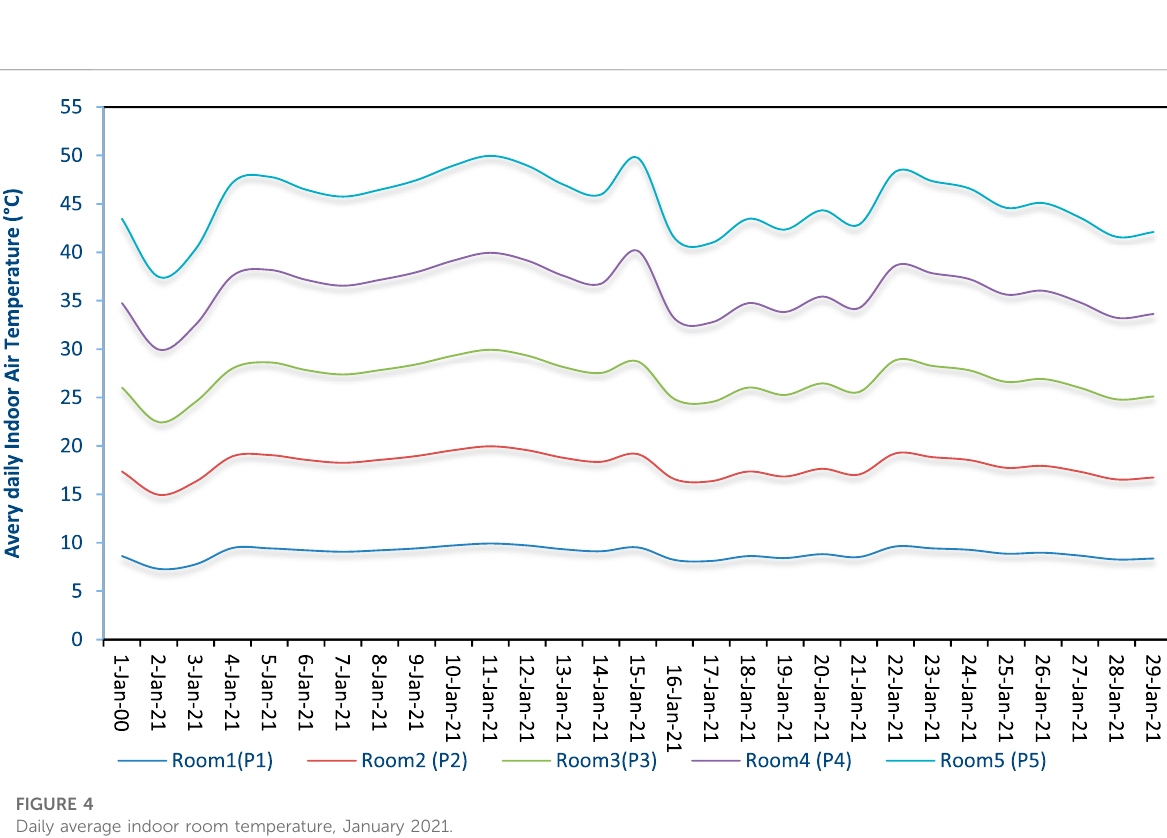
FIGURE 4 Daily average indoor room temperature, January